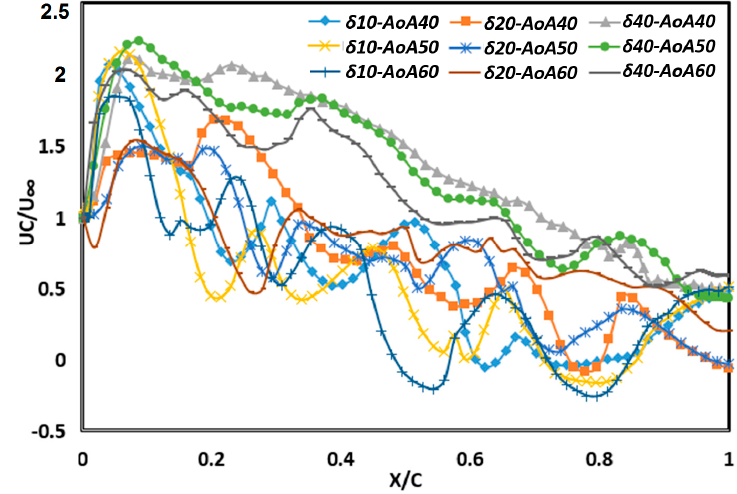
Figure 8. Graph of non-dimensional axial velocity ( U c / U ∞ ) along the main wing of the vortex core.